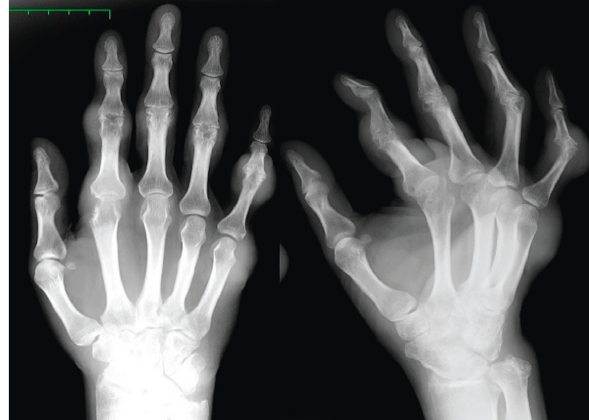
Figure 2: Preoperative radiograph of the right hand showing gouty arthritis and inflammatory osteolysis with numerous calcified soft tissue swellings, especially in the proximal interphalangeal joints of the index, middle, and little fingers.